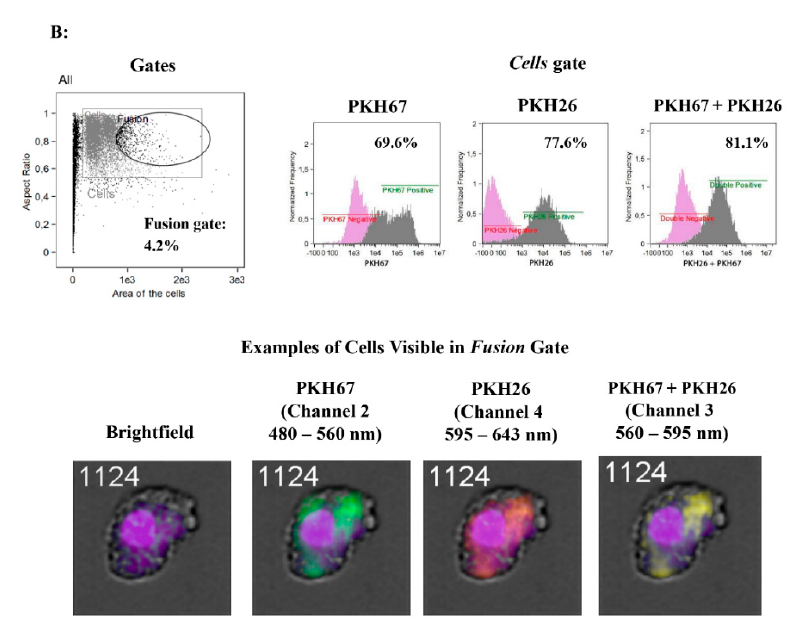
Figure 6. Spontaneous fusion between BM-MSCs and SM-SPCs in vitro. A representative illustration of co-cultured cells obtained from Donor 1. ( A ) Immunofluorescence staining with PKH26 (red) for BM-MSCs and PKH67 (green) for SM-SPC revealed fused cells between SM-SPCs (green multinucleated cells) and between BM-MSCs and SM-SPCs (yellow/orange) as early as 24 h after the co-culture was started. The areas limited by grey lines are enlarged by zoom. ( B ) To confirm the spontaneous fusion between BM-MSCs and SM-SPCs, the mixed co-culture was detached from the culture plate on day 6, and single cells were analysed with flow cytometry to assess the presence of cells revealing double-merged fluorescence signals. Flow cytometry analysis showed cell populations with fluorescence emission in the 480–560 nm spectrum (Channel 2) characteristic for PKH67, the 595–643 nm spectrum (Channel 4) characteristic for PKH26, and the 560–595 nm spectrum (Channel 3), which suggests the immersion of two dyes with each other.